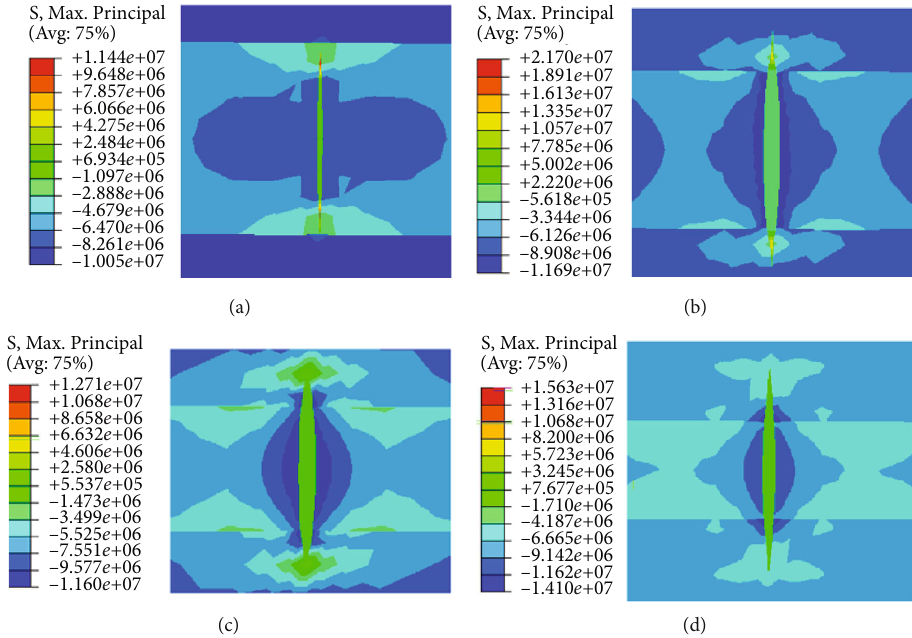
Figure 24: E ff ect of temperature and injection rate on hydraulic fracturing height at di ff erent times: (a) 10 steps, (b) 20 steps, (c) 40 steps, (d) 50